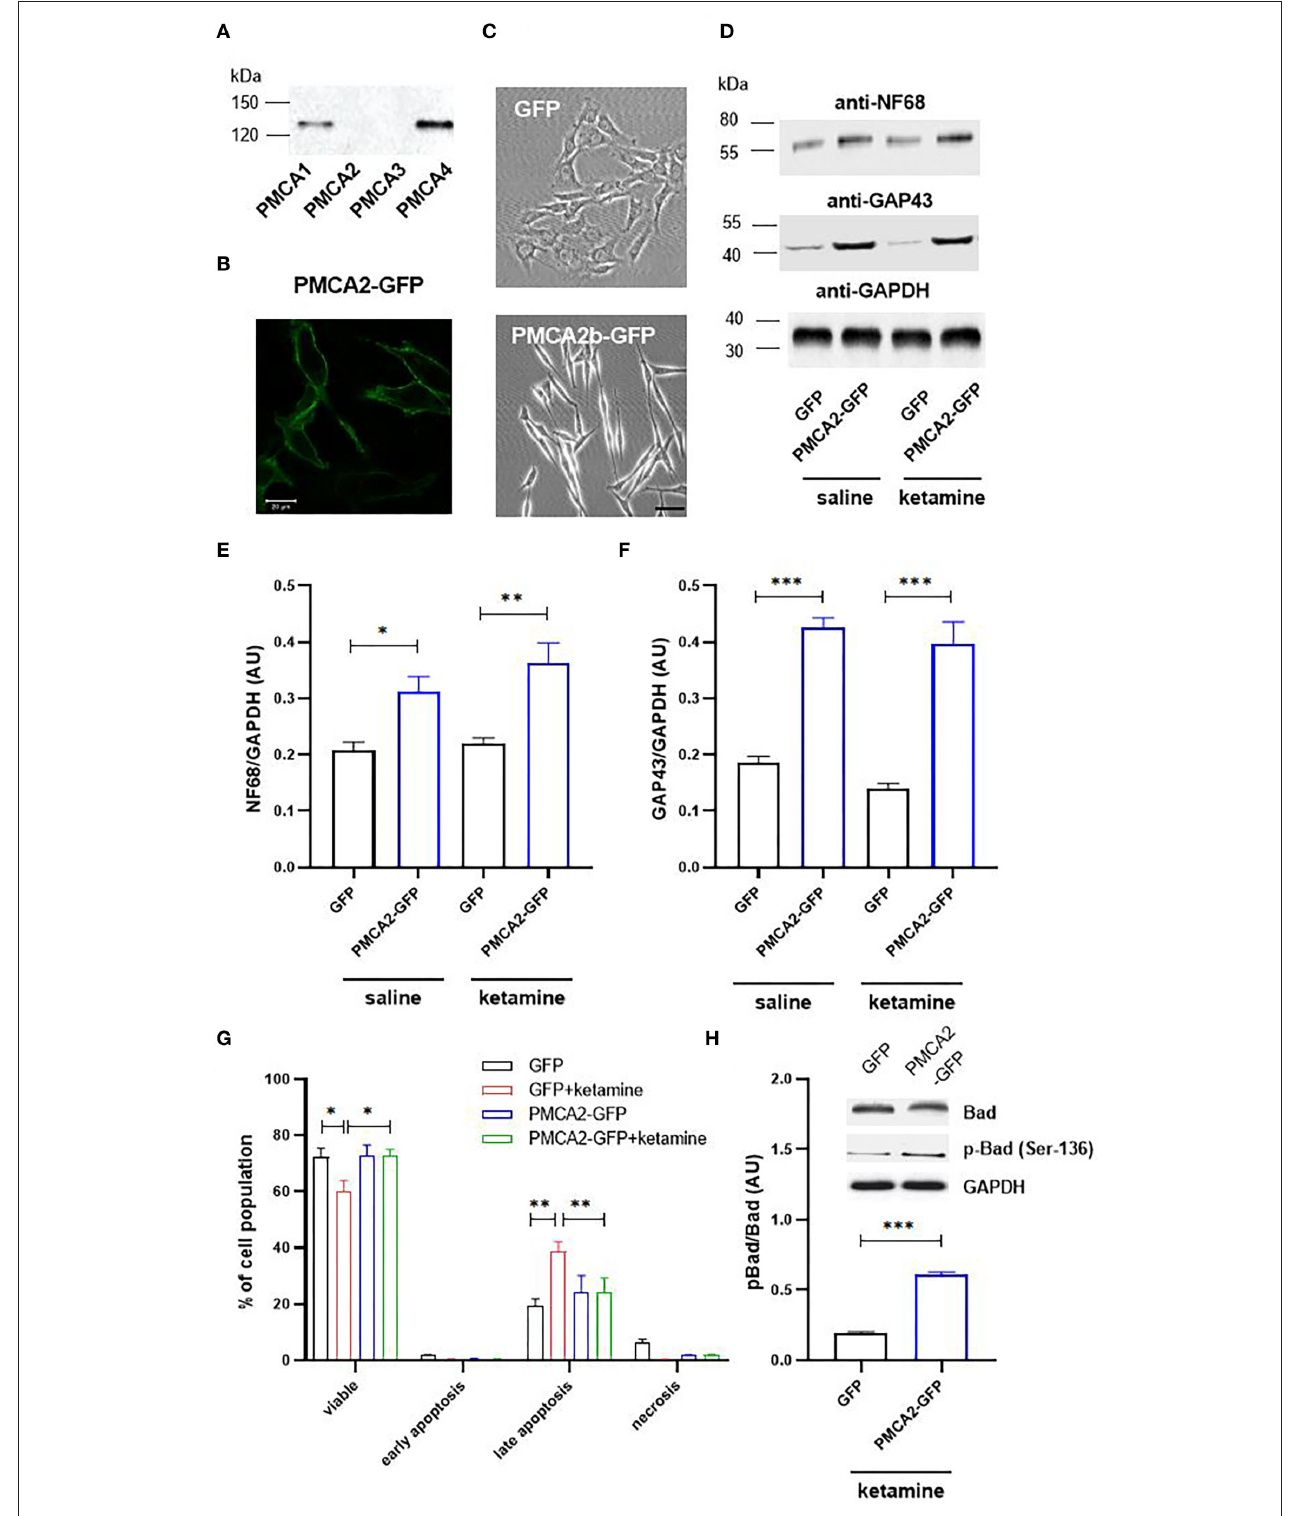
FIGURE 1 | PMCA2b expression enhances H19-7 cell differentiation and restricts ketamine-mediated apoptosis. (A) The presence of PMCA isoforms determined using the Western blot. (B) The expression of PMCA2b-GFP and the targeting of the fusion protein to the plasma membrane visualized using immunocytochemistry. Scale bar 20 µ m. (C) The effect of PMCA2b expression on cellular morphology in the absence of a differentiating agent. Scale bar 50 µ m. (D) The protein level of